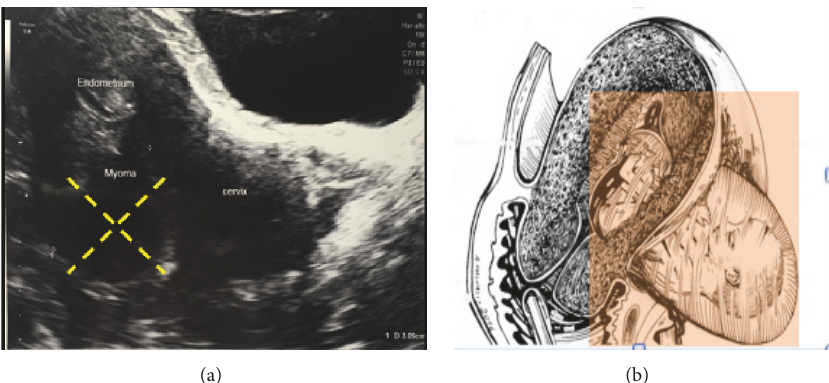
Figure 2: (a) 2D transvaginal ultrasound of the IM isthmic myoma type 5. (b) Graphic depiction of the herniated fetus through the isthmic defect on the previous myomectomy